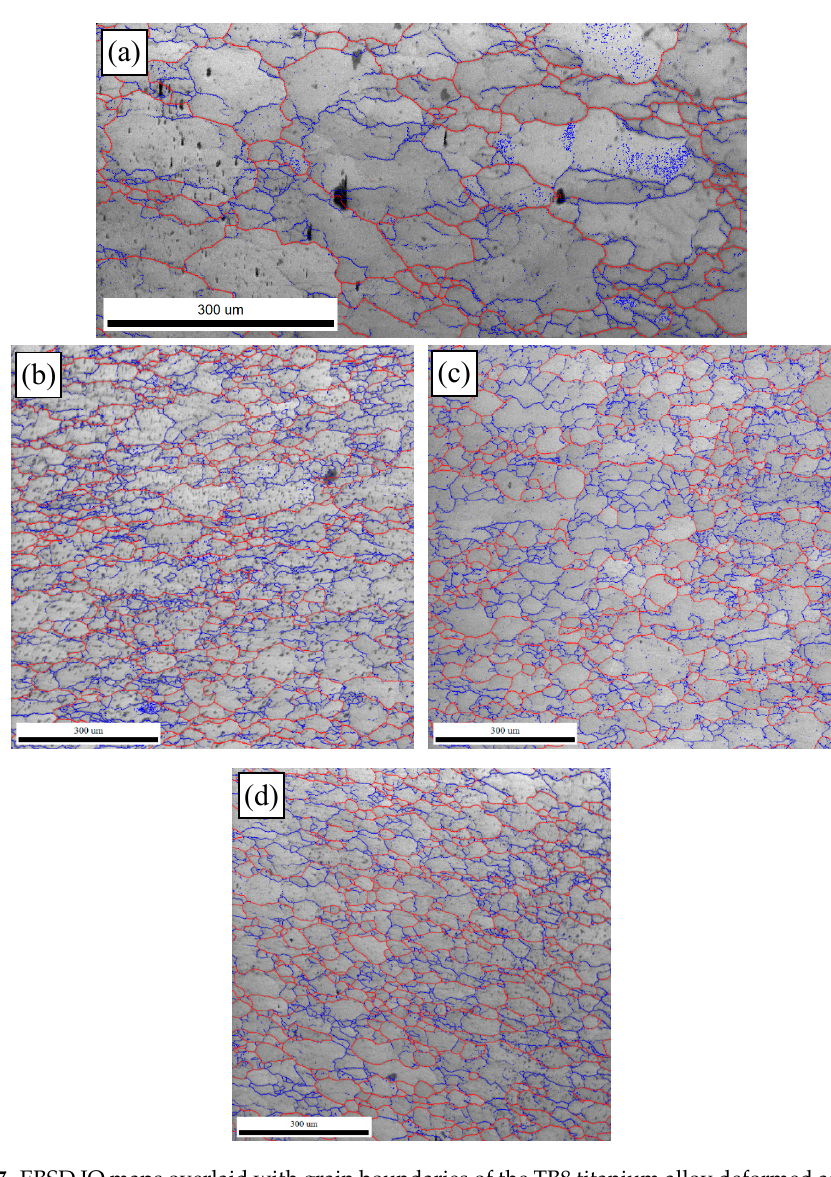
Figure 7. EBSD IQ maps overlaid with grain boundaries of the TB8 titanium alloy deformed at different strains of ( a ) 0.2, ( b ) 0.4, ( c ) 0.6 and ( d ) 0.8.